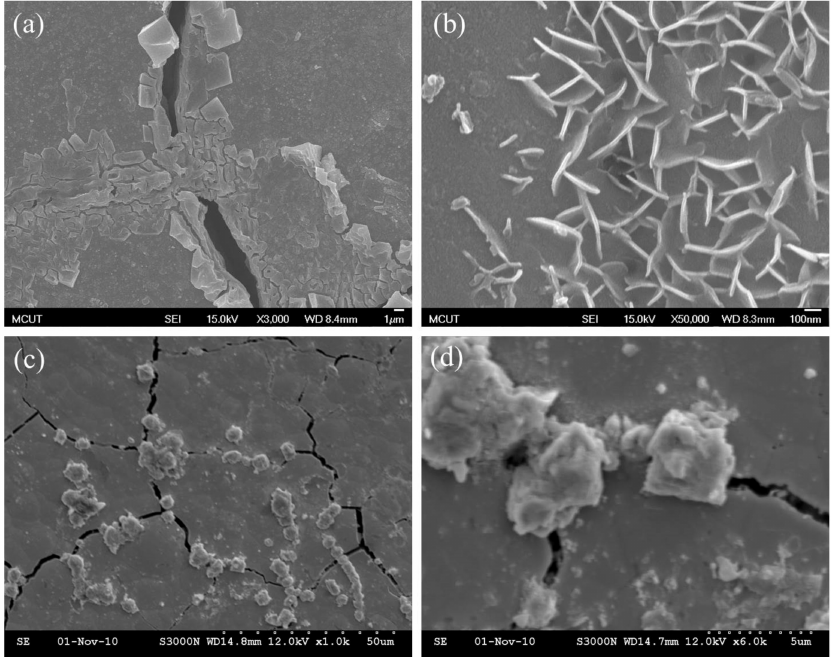
Figure 10. Surface morphology of the heat-hardened Cr–C / Cu-coated sample potentiostatically etched at 0.5 V in 0.1 M H 2 SO 4 + 1 g / L NaCl solution, ( a ) and ( b ) for 900 s, as well as ( c ) and ( d ) for 1200